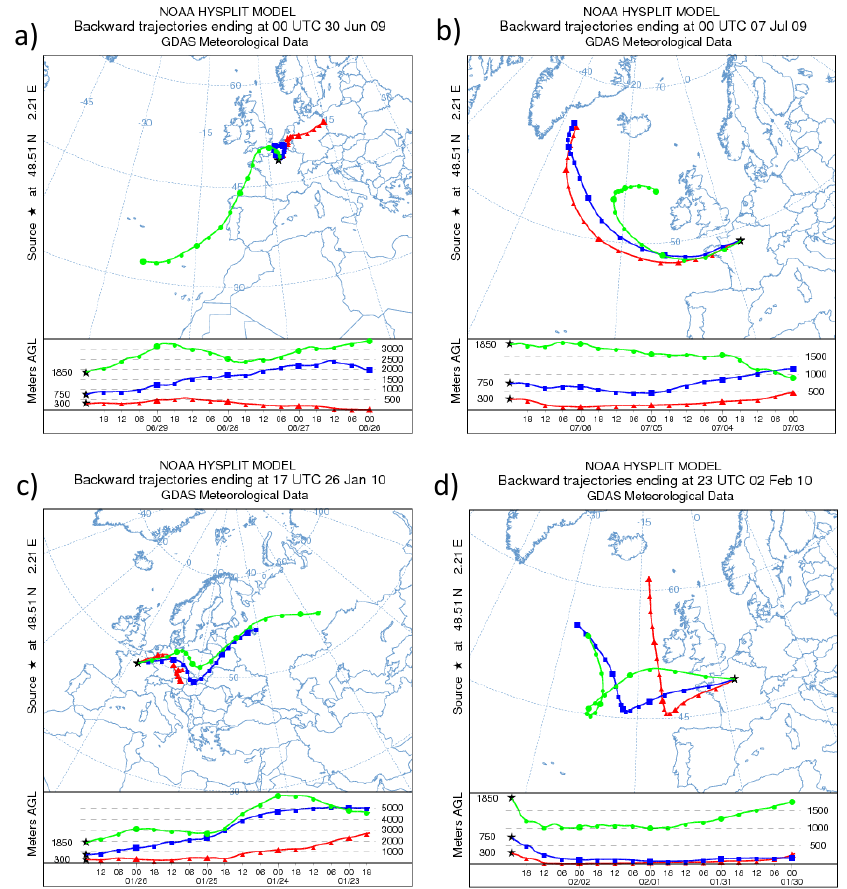
Fig. 8. HYSPLIT trajectories for the 2 periods in summer (top) and winter